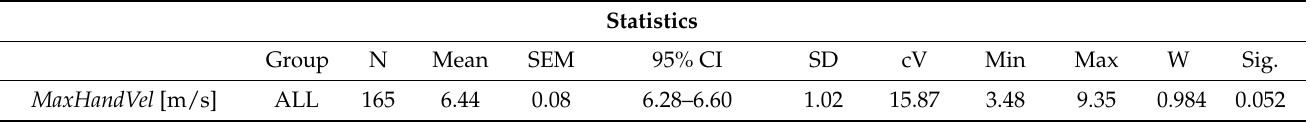
Table 2. The descriptive statistics for the maximal achieved hand velocity in relation to the overall sample.